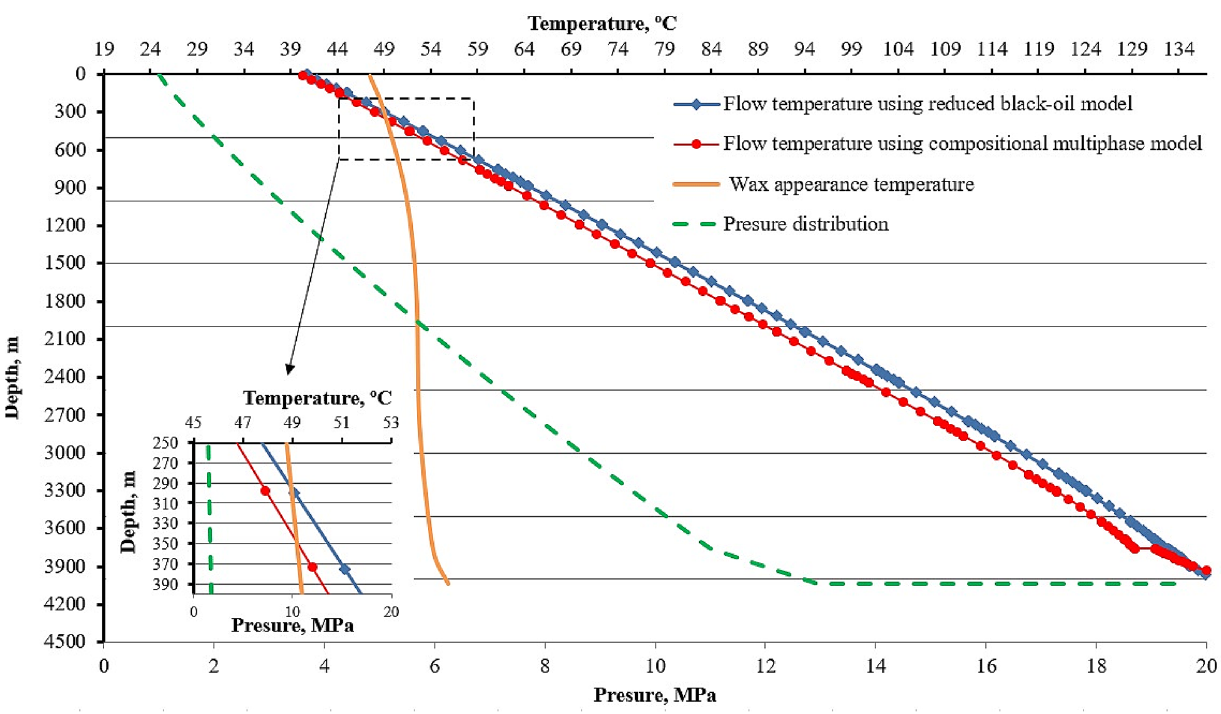
Fig. 5 Determination of wax formation depth in the gas-lift